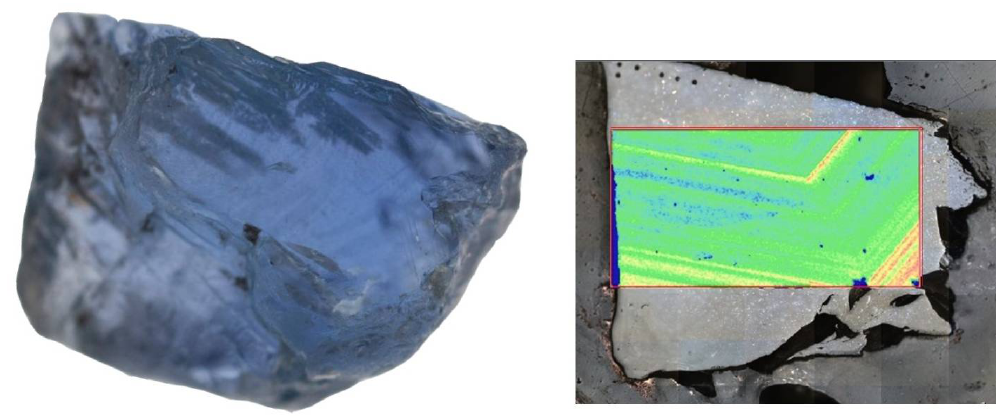
Figure 17. Photo of a Burmese blue sapphire wafer with homogeneous blue coloration ( left ). On the ( right ) is the Cr distribution map of the same sapphire created by PL mapping.